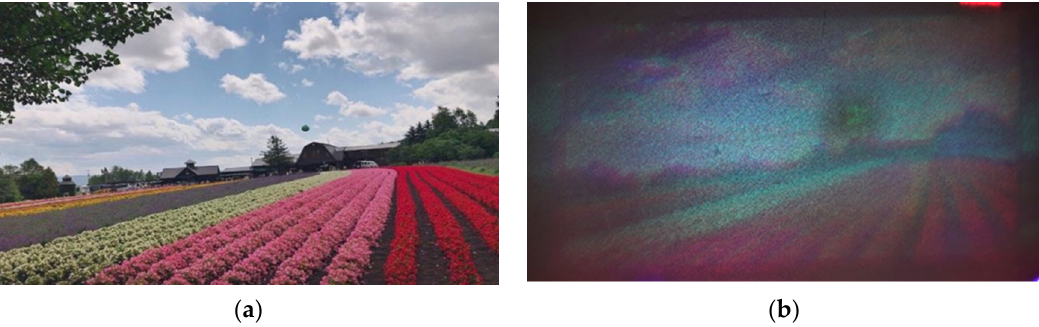
Figure 11. Colored original image ( a ) and full-color reconstruction ( b ).